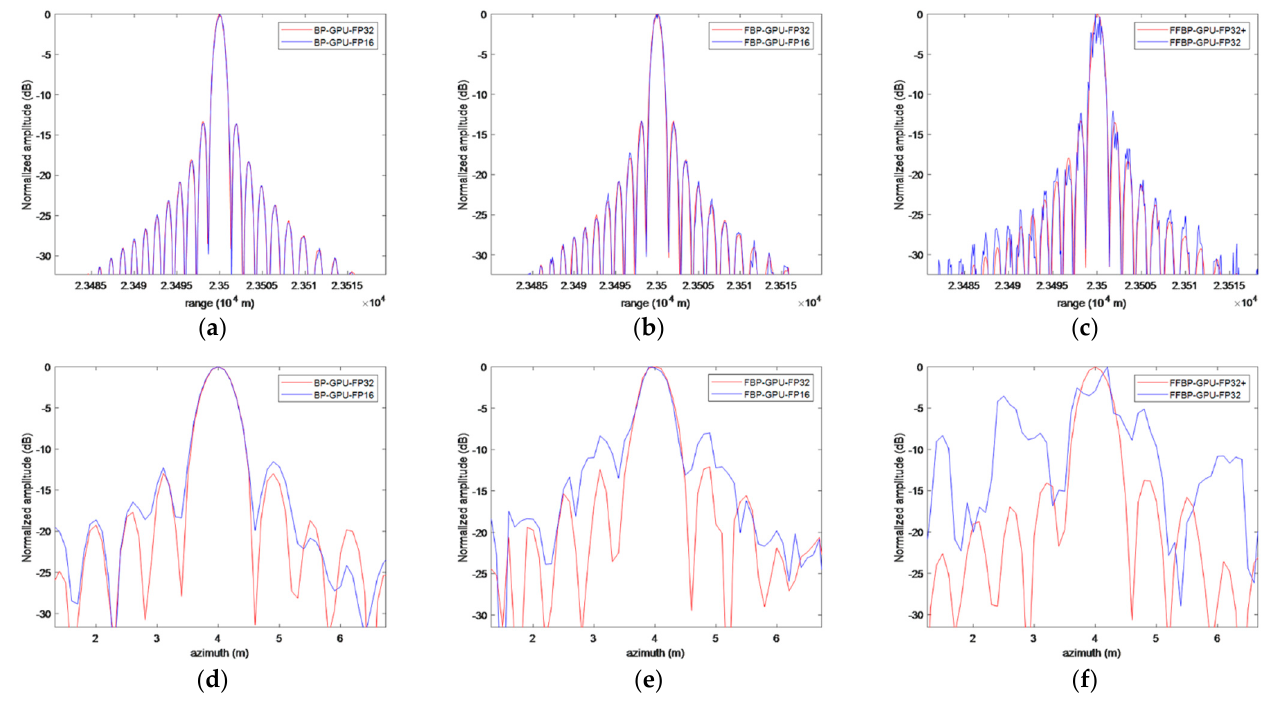
Figure 11. The normalized amplitude diagrams for a point target. ( a ) BP-GPU-FP32 and BP-GPU-FP16 in range direction; ( b ) FBP-GPU-FP32 and FBP-GPU-FP16 in range direction; ( c ) FFBP-GPU-FP32+ and FFBP-GPU-FP32 in range direction; ( d ) BP-GPU-FP32 and BP-GPU-FP16 in azimuth direction; ( e ) FBP-GPU-FP32 and FBP-GPU-FP16 in azimuth direction; ( f ) FFBP-GPU-FP32+ and FFBP-GPU-FP32 in azimuth direction. Table 4. Imaging indicators of the four GPU